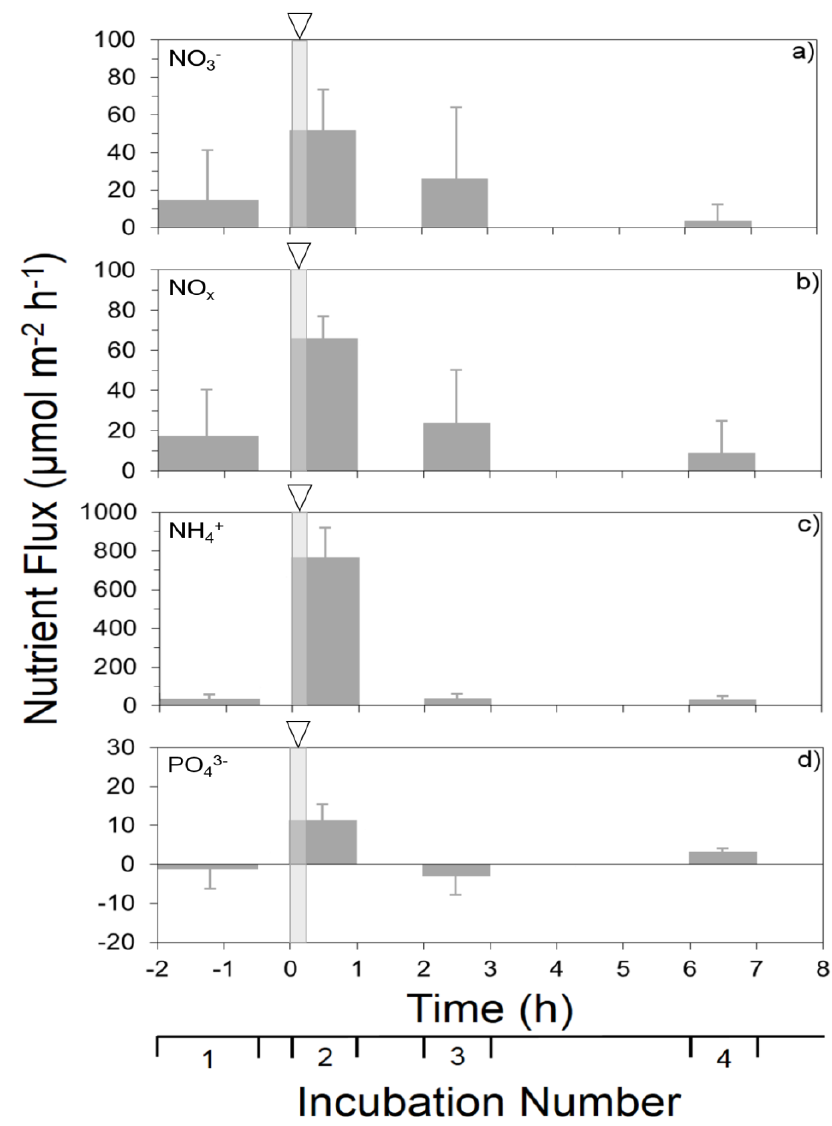
Figure 3. Calculated fluxes for ( a ) NO 3− , ( b ) NO x , ( c ) NH 4+ , and ( d ) PO 43− during core incubations. The occurrence of the sediment disturbance and resuspension event is represented by ▽ and shading.